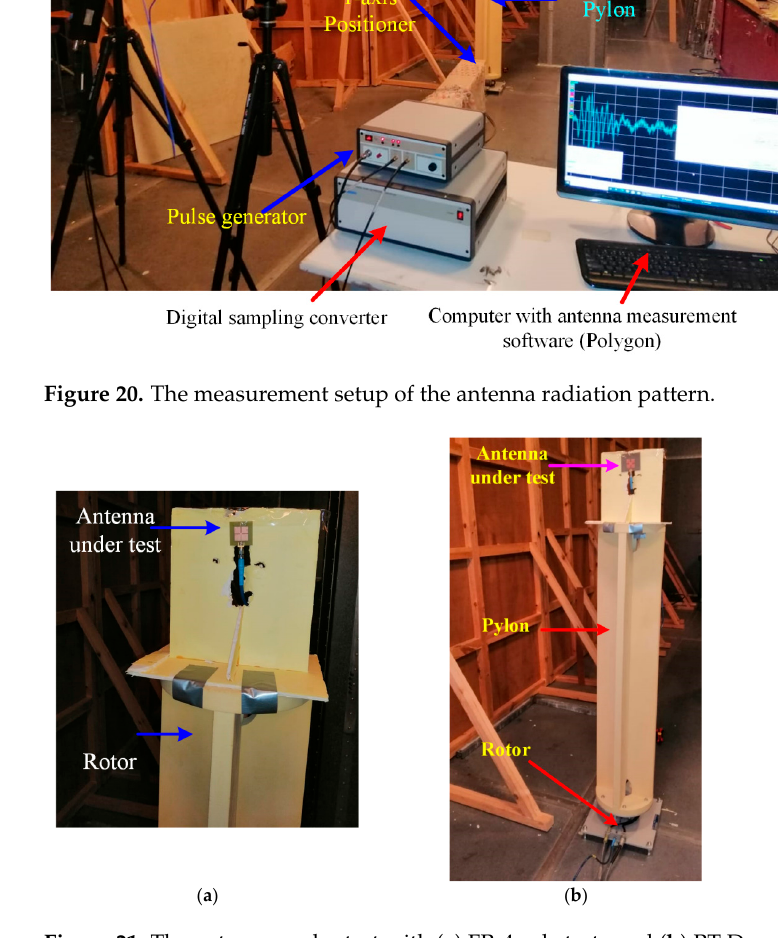
Figure 21. The antenna under test with ( a ) FR-4 substrate and ( b ) RT Duroid 5880 substrate.